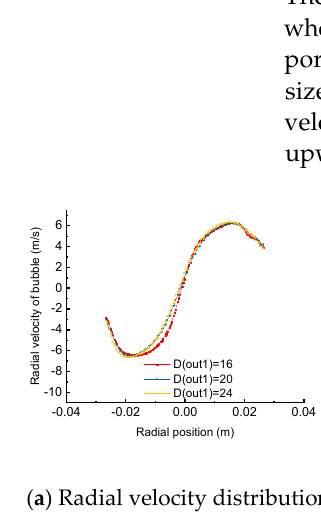
Figure 4. Static pressure distribution curve of section Z.